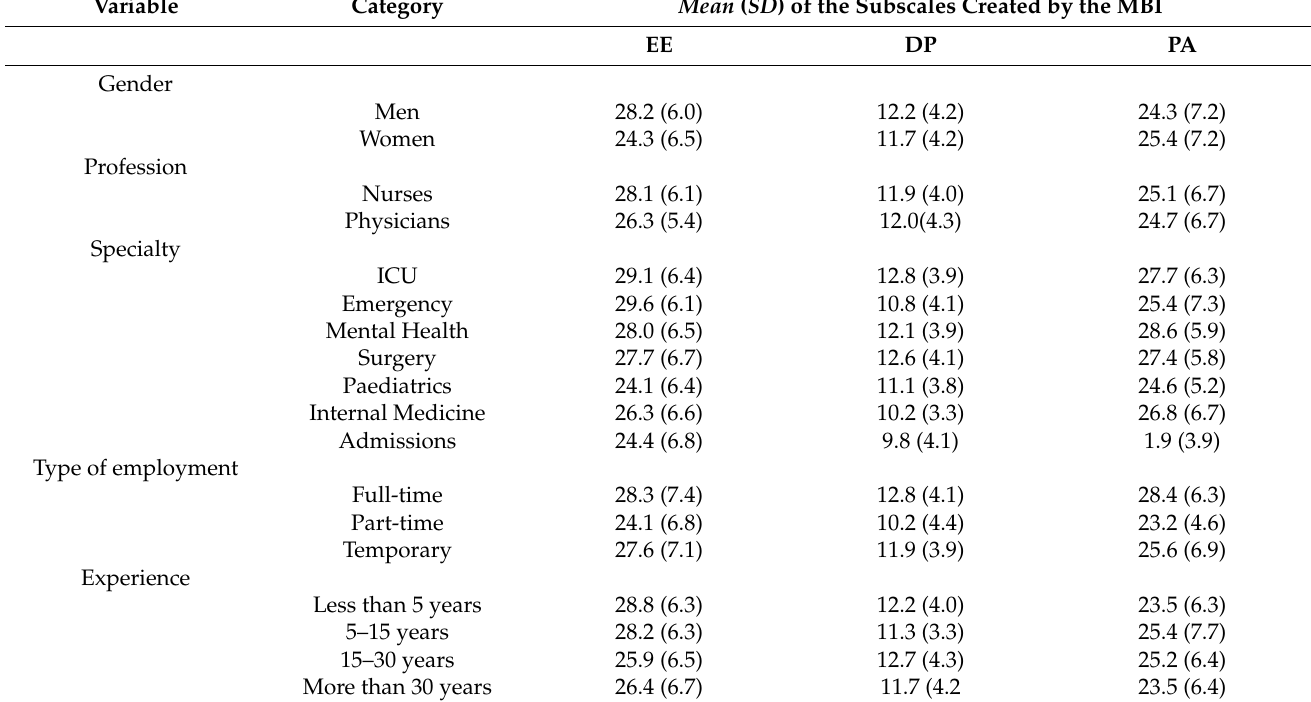
Table 3. Results of the mean of the different levels that make up